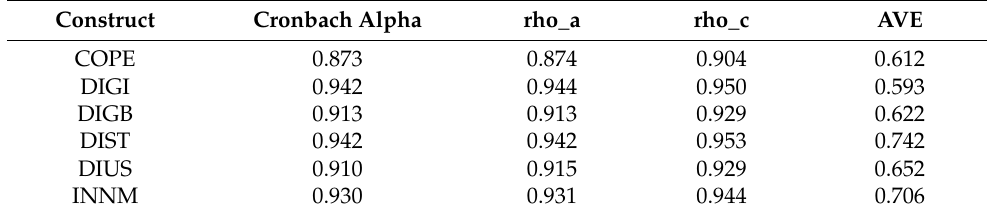
Table 3. Reliability and validity of the